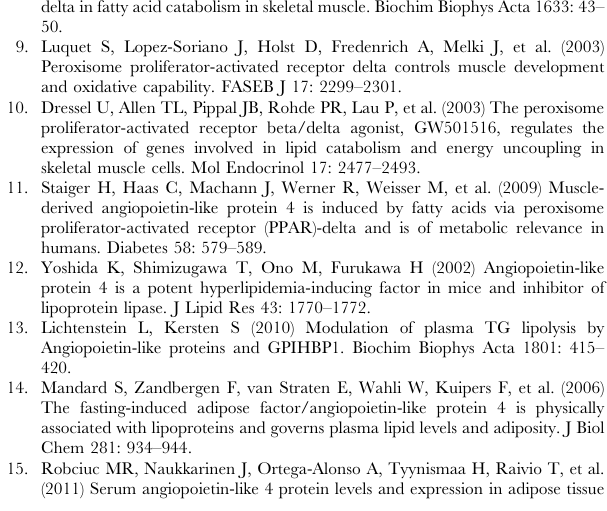
Figure S1 Angptl4 mRNA during differentiation of human myotubes. Angptl4 and PBGD mRNA levels were measured by real time PCR on day 2, 5 and 7 of differentiation in myoblasts derived from four men. Values are expressed as fold increase relative to day two of differentiation and normalized to human b Actin mRNA levels, mean 6 SEM, n= 4. * p , 0.05, Student’s t test. Figure S2 Effect of GW501516 on Angptl4 and LPL mRNA in C2/LPL cells and LPL activity in human post heparin plasma. ( a ) Angptl4 and LPL mRNA levels were measured by real time PCR in C2/LPL myotubes incubated with DMSO (Control) or GW501516 (0.1 m M) for 1–4 hours. Values were normalized to m36B4 levels and expressed as mean 6 SEM, n =3. ( b ) LPL activity was measured in human post-heparin plasma was incubated with DMSO or GW501516 (50 m M) for 1 hour at RT. * p , 0.05, Student’s t test. Figure S3 Mice were injected with HSA-AAV9 (n= 3) or Angptl4-AAV9 (n= 3) into tibialis anterior muscles and intraperitoneally. Two weeks after injections plasma ( a ) Angptl4 levels and ( b ) triglycerides were measured by ELISA and enzymatic colorimetric assay respectively. Values are expressed as mean 6 SEM of 3 animals per group. * p , 0.05, Student’s t test.